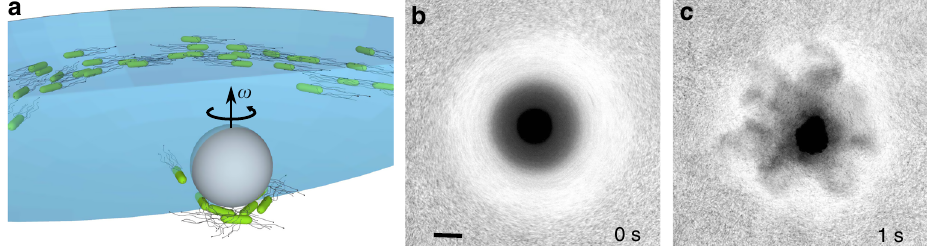
Fig. 1 Illustration of droplet instability. a Three-dimensional schematic representation of the experimental setup. A 60 μ m nickel particle is spun by an external magnetic fi eld inside a pendant drop with swimming bacteria. Rotation of the particle creates a vortex; the vortex redistributes bacteria and forms a dense bacterial droplet. b Stable bacterial concentration distribution for rotation frequency of 400Hz. Scale bar is 50 μ m. c Vigorous explosion of the concentrated bacterial droplet 1 s after cessation of